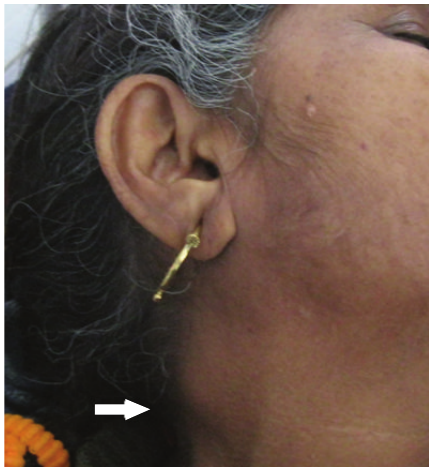
Figure 1: Enlarged right cervical lymph node, 2 × 1 . 5cm.